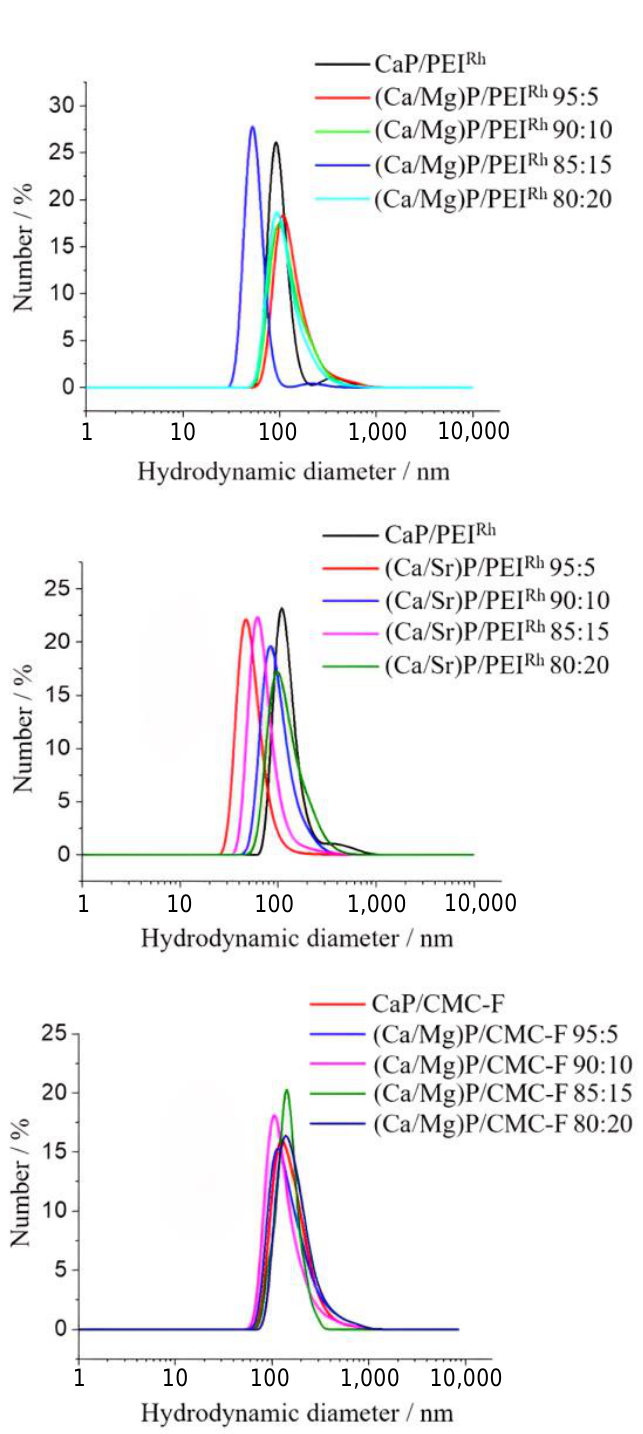
Figure 3. Dynamic light scattering results of undoped and magnesium- or strontium-doped calcium phosphate nanoparticles, stabilized and labelled with either PEI Rh or CMC-F. Neither particle composition nor surface functionalization had a significant effect on the particle size distribution (represented by particle number distribution). No larger agglomerates were detectable.